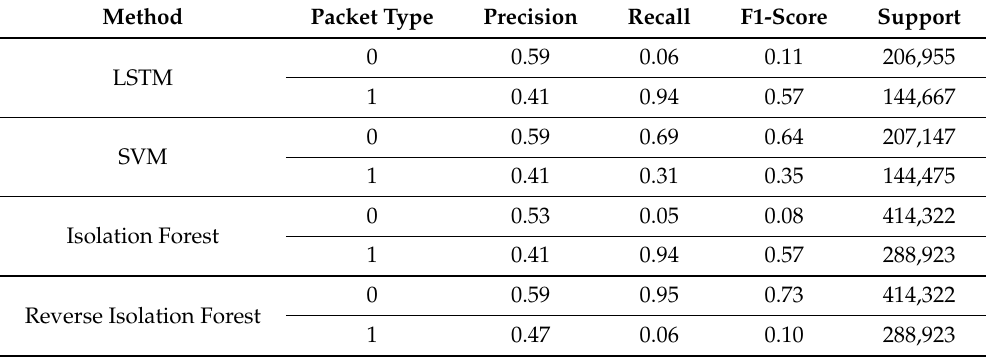
Table 5. The models’ metrics after validation for a single day from the CIC-IDS2017 dataset.